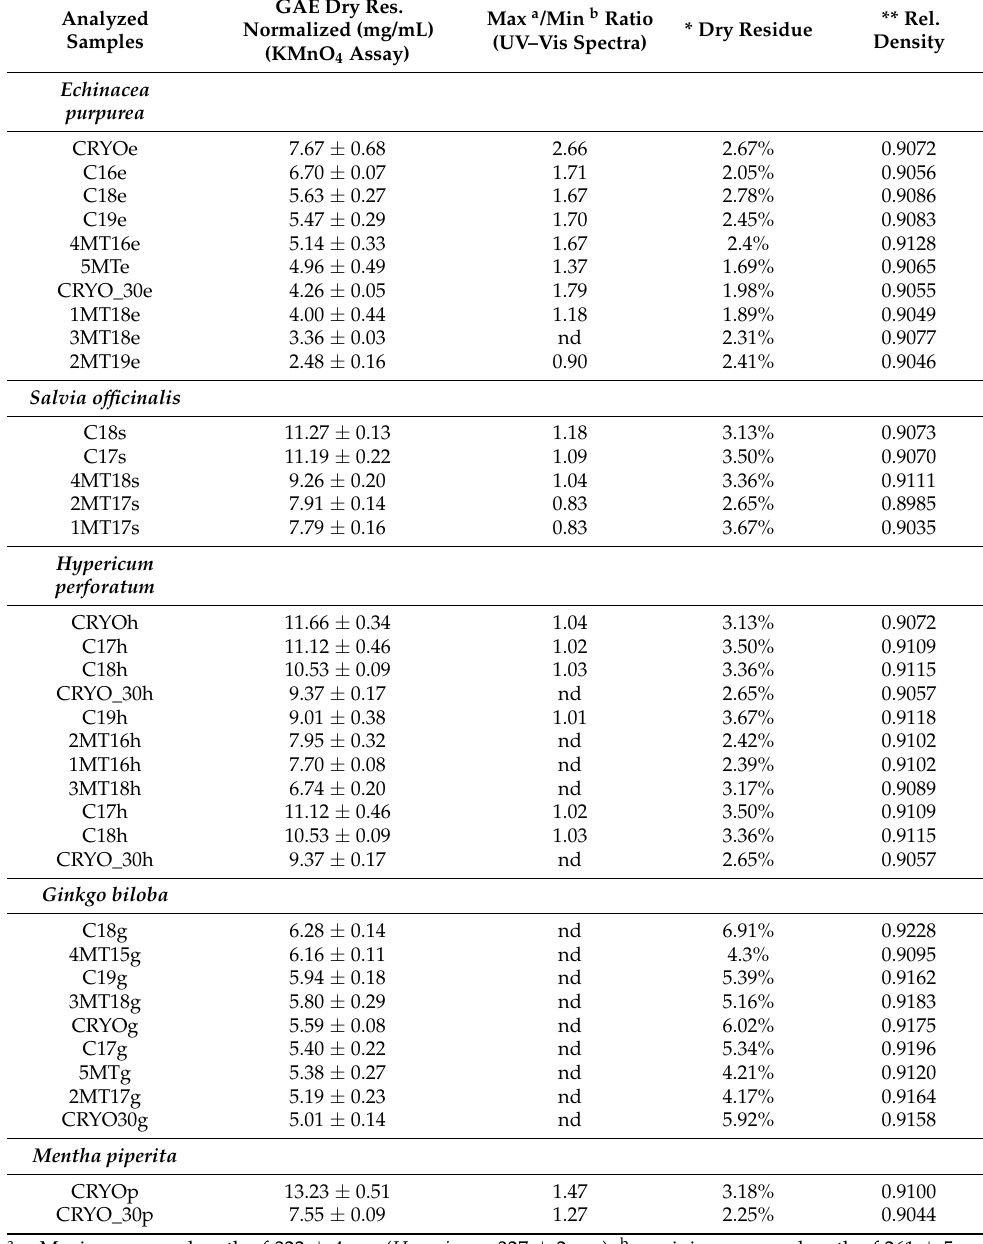
Table 1. Results of MTs laboratory